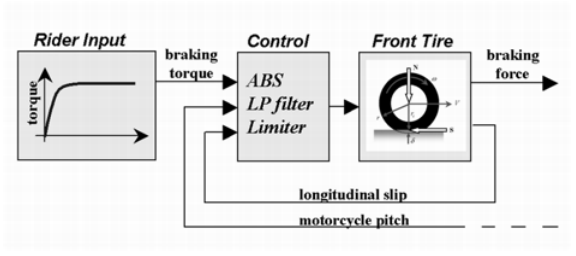
Table 2. Process integration